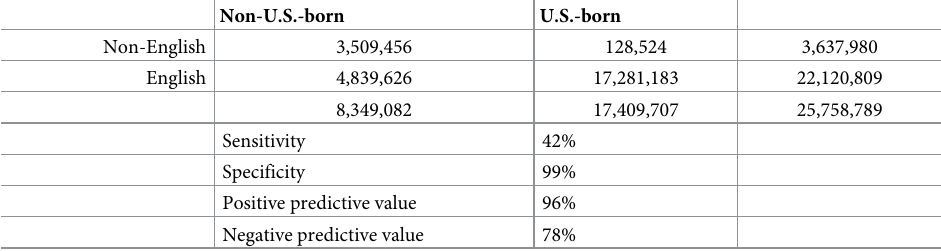
Table 3. Language at medical visit by nativity, California 2014–2017.